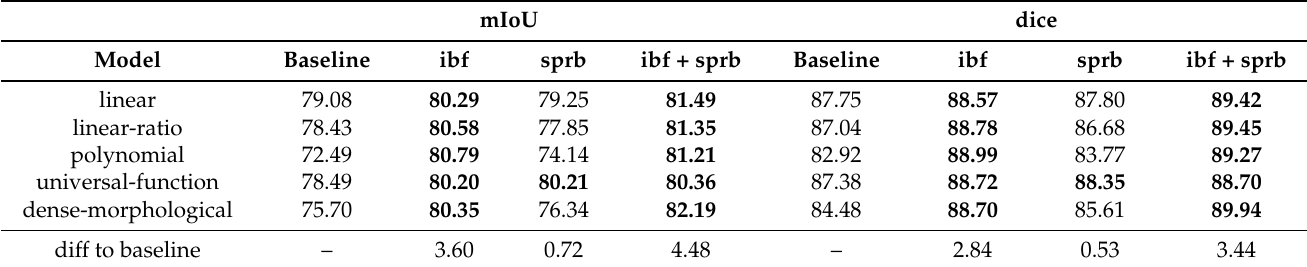
Table 6. Scores of DeepIndices with/without ibf and sprb for a kernel size of 7. mIoU